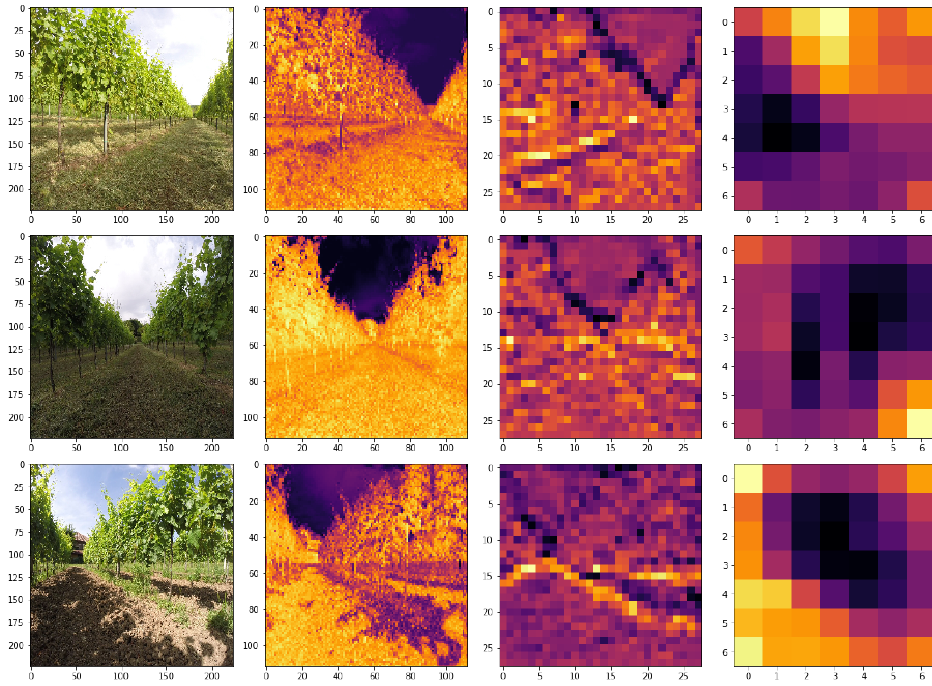
Figure 6. Three input images belonging to different classes, with their respective activation maps taken at different level of depth of the network. Already on early stages, the network, pre-trained on ImageNet, is able to extract useful representations that lead at robust, disentangle activations in the final layers. It is possible to notice how the two spacial dimensions are increasingly